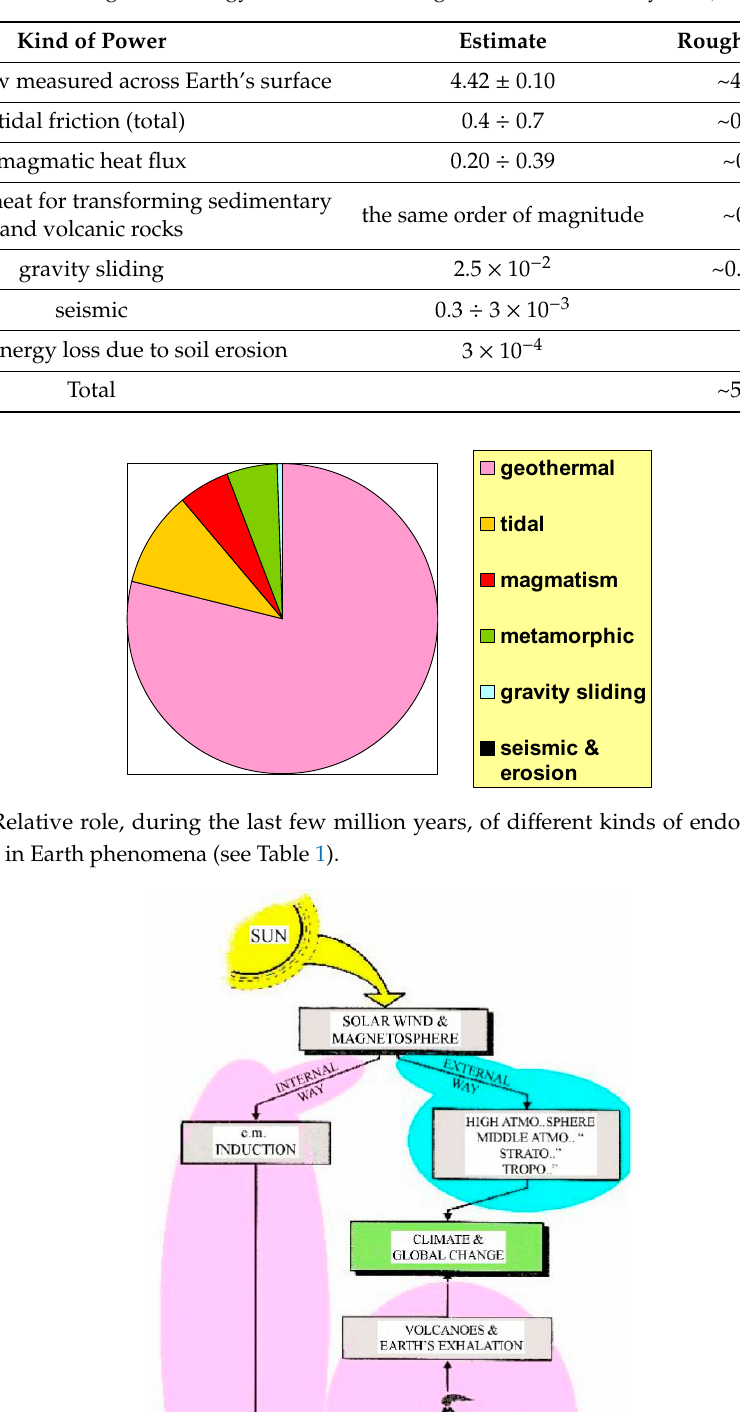
Table 1. Endogenous energy of the Earth during the last few million years ( × 10 13 W).